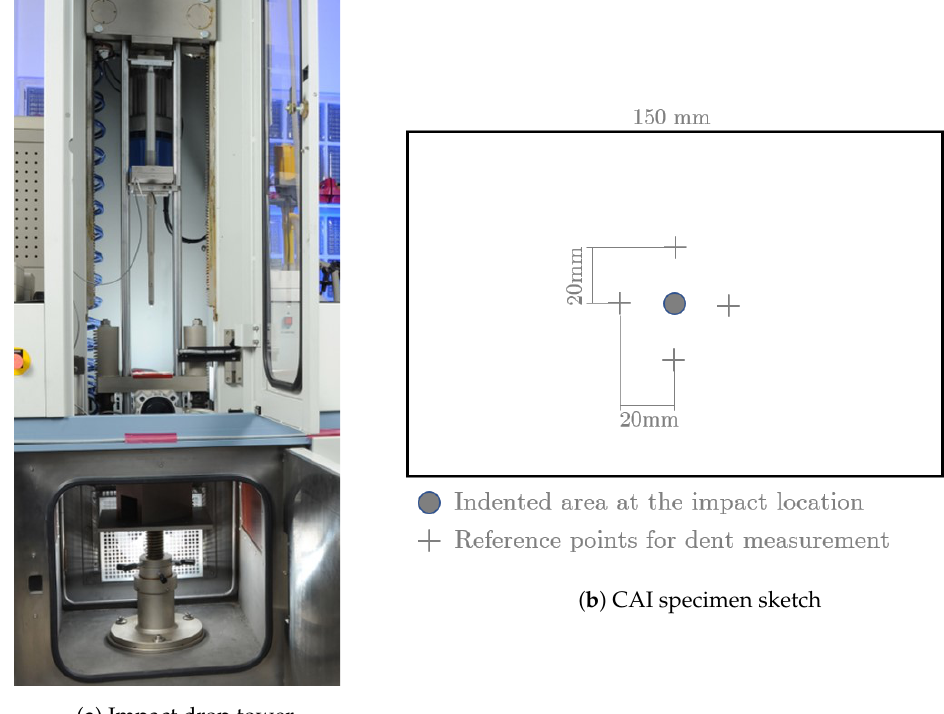
Figure 1. CEAST Fractovis impact drop tower for the impact tests ( a ) and a sketch of the CAI standard specimen ( b ) according to AITM 1.0010